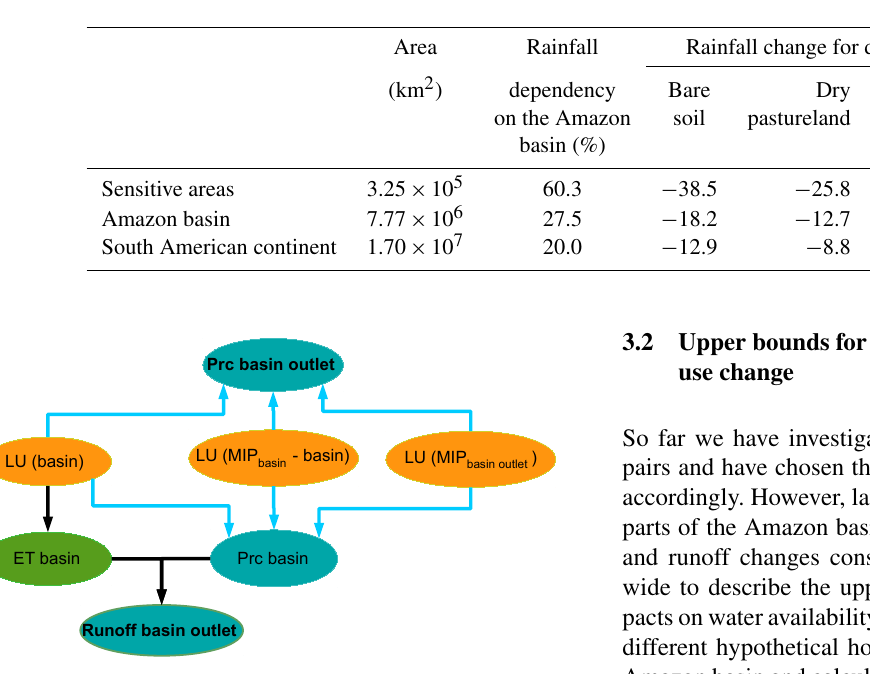
Table 4. Estimated changes in annual rainfall over different regions when applying various land use scenarios in the Amazon basin. Note that annual rainfall is reduced continental-wise, but the sensitive areas experience greater reductions.